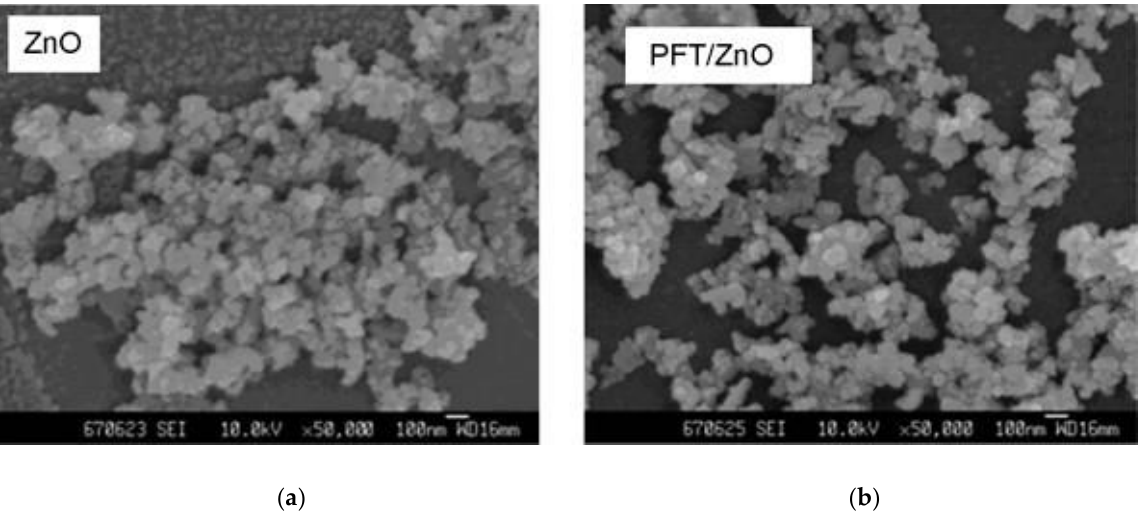
Figure 4. TEM images of the ( a ) ZnO and PFT/ZnO ( b ). (Reprinted with permission from Ref. [46], © Elsevier 2008).